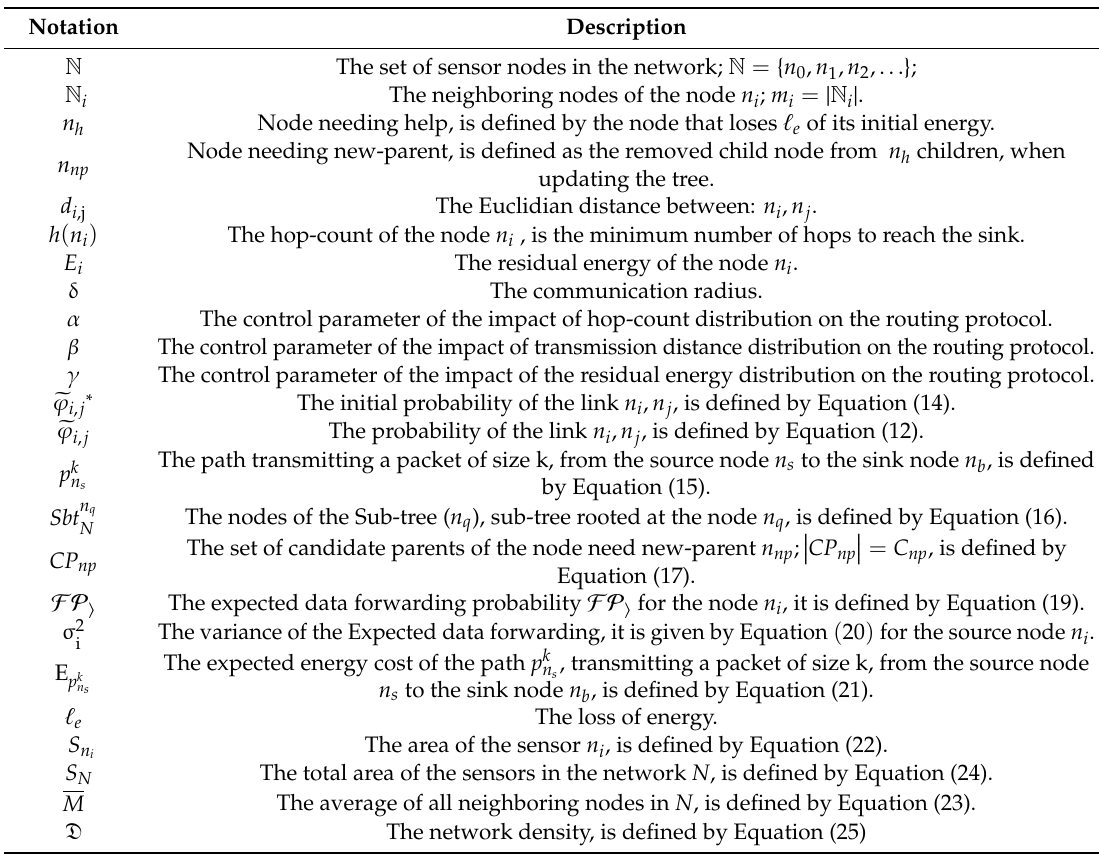
Table 1. Notations.